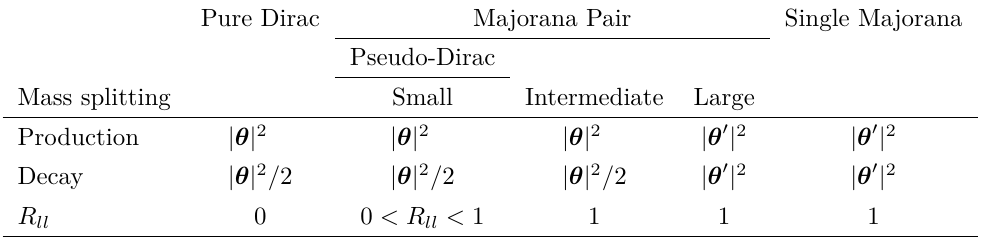
Table 3 . Production ratios and decay widths for different types of heavy neutrinos. The primed mixing parameters occur in models without mass mixing between two heavy states, while the unprimed mixing parameters occur in models with mass mixing between the two heavy neutrinos. part of generated events are now LNV leading to 0 < R ll < 1 . However, the arguments for the production and decay of a pure Dirac particle apply also to this